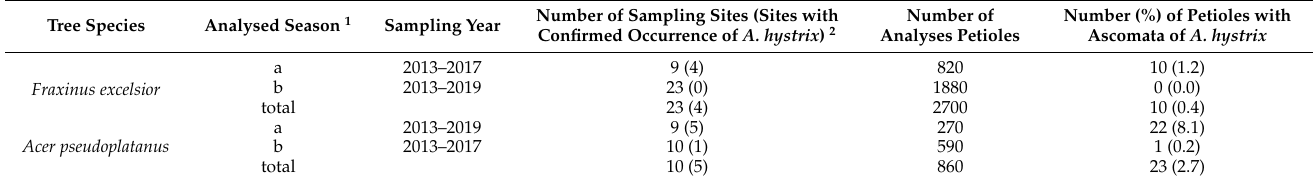
Table 2. Occurrence of Apiognomonia hystrix ascomata on overwintered leaf petioles of Fraxinus excelsior and Acer pseudoplatanus